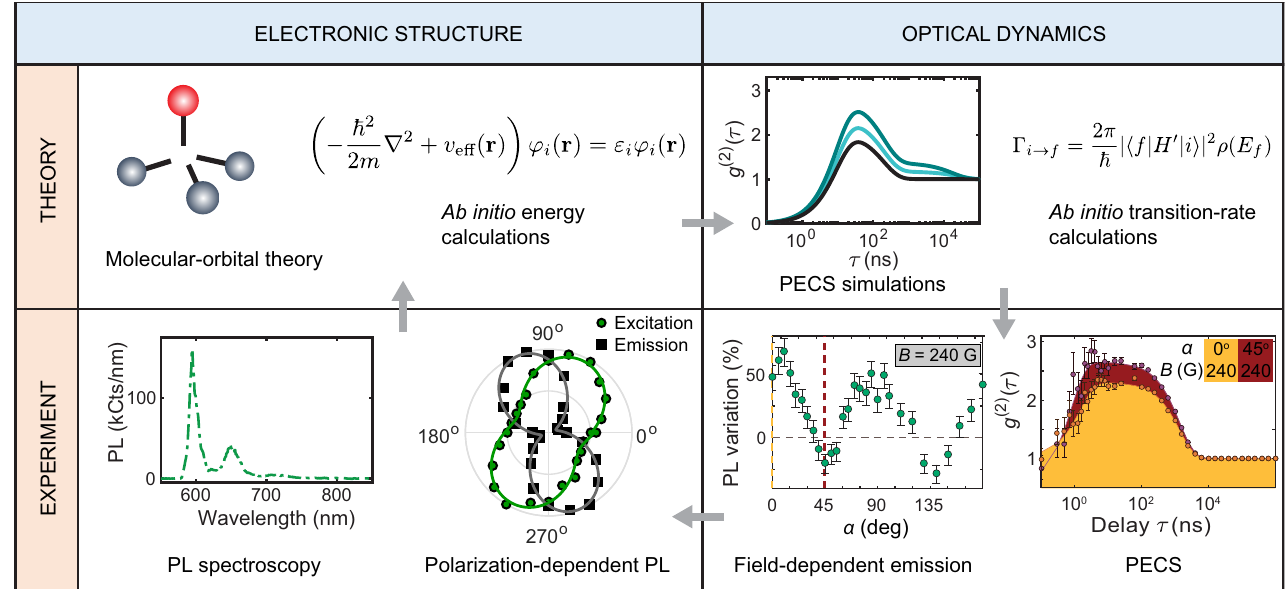
FIG. 6. A nonexhaustive chart of the tools to study quantum emitters. A variety of techniques, both experimental and theoretical, can give information about the electronic structure and optical dynamics of a quantum emitter. Tools that help clarify electronic structure include experimental techniques, such as PL spectroscopy and polarization-dependent PL, and theoretical techniques of molecular-orbital theory and ab initio energy calculations. Tools that help uncover optical dynamics include theoretical techniques such as PECS simulations and ab initio transition-rate calculations, which should be supplemented with experimental techniques such as field-dependent emission and PECS measurements. The images in the lower-left quadrant depict h -BN data adapted from Patel et al. [84]. The images in the lower-right quadrant depict h -BN data adapted from Exarhos et al. [87]. measurements that help identify optical spin